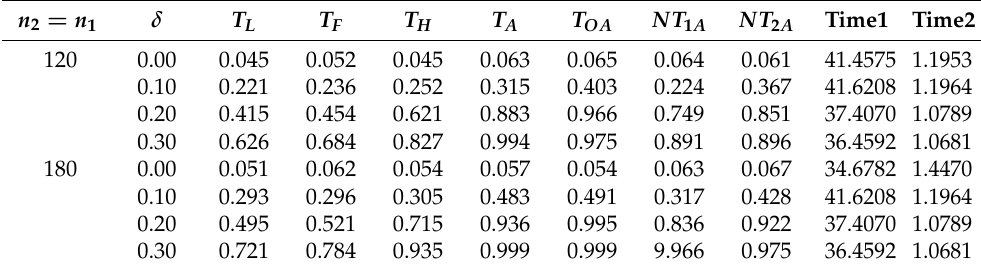
Table 9. Size and power of seven methods under randomized signal in Setting 2 M ( 40,6 ) .